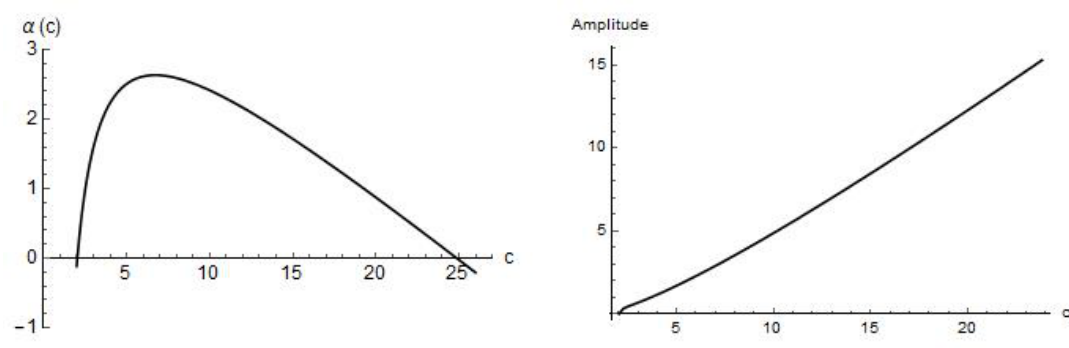
Figure 4. The local extremum of function (15) on I c is the maximum at the point c = 6.726 with the value α = 2.633 while the amplitude of the limit cycle increases on the whole interval I c .